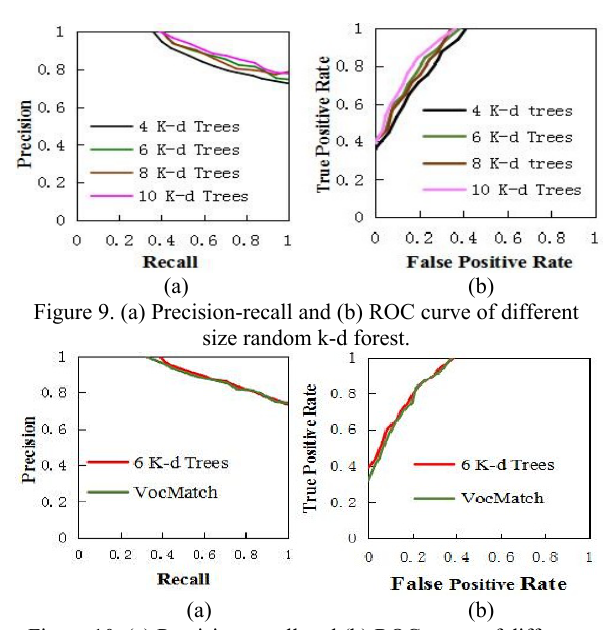
Figure 10. (a) Precision-recall and (b) ROC curve of different